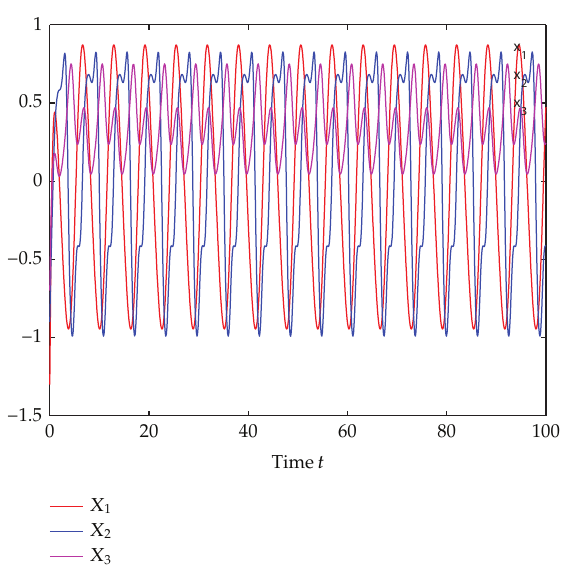
Figure 3: Transient response of state variables x 1 ,x 2 and x 3 in Example 4.9.